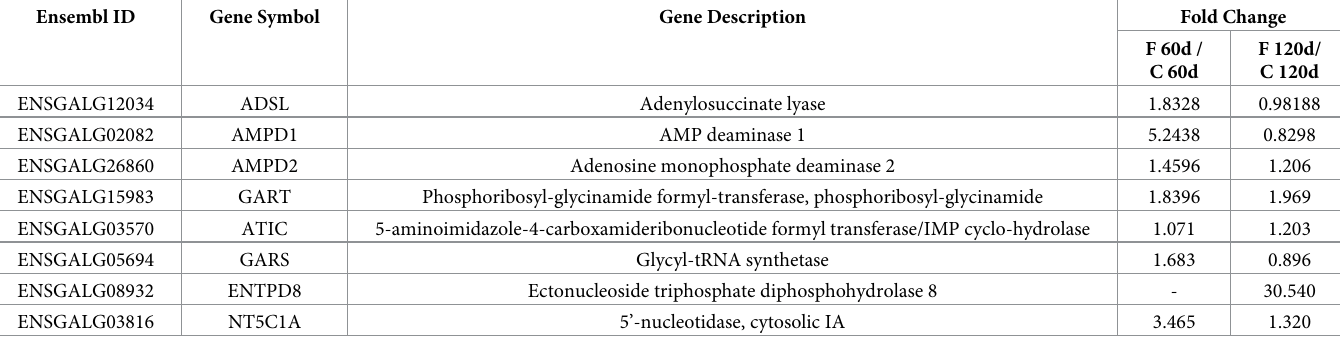
Table 5. Differentially expressed genes involved in IMP synthesis and